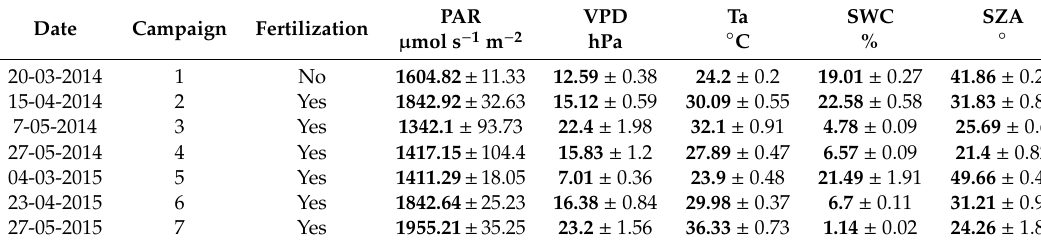
Table 1. Summary of the main meteorological data collected in each field